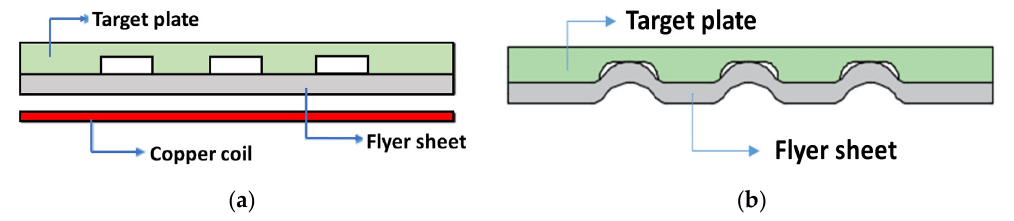
Figure 5. Schematics of the sample configuration ( a ) before and ( b ) after the joining process.